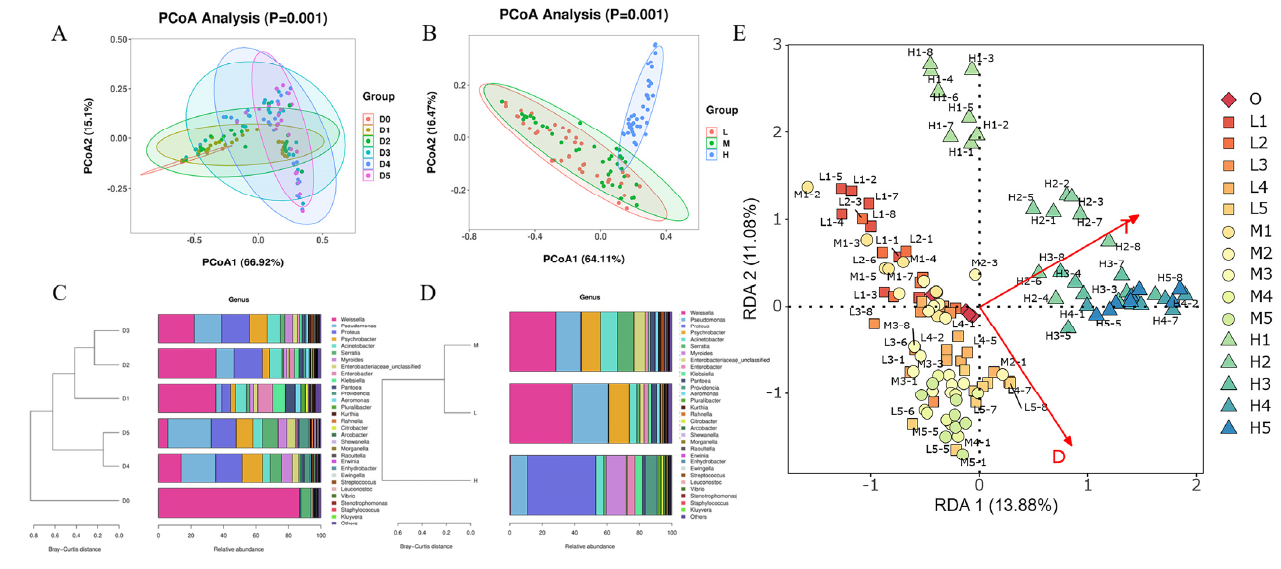
Figure 3. Principal component analysis based on ( A ) storage time and ( B ) temperature. Cluster analysis in the RTE chicken meat samples based on ( C ) storage time and ( D ) temperature at the genus level. ( E ) Redundancy analysis (RDA) of correlations between environmental factors and bacterial community composition.